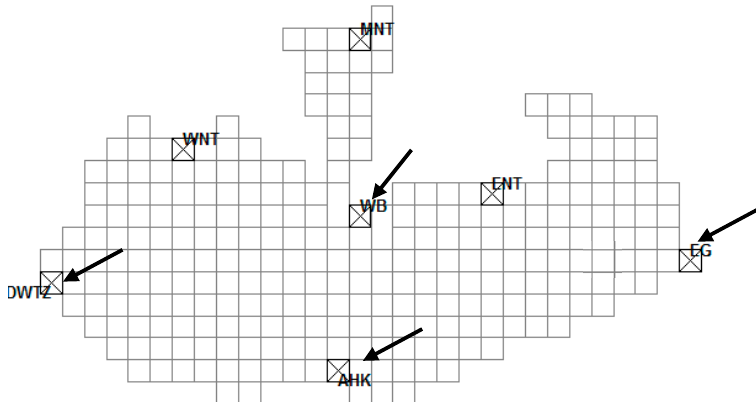
Figure 3. The computational grids and input and output boundary in the model (where the grids with a cross are the inlet and outlet cells, in which WB represents the inlets of the west branch of Kaidu River; DWTZ and AHK represent Dawutizha gate, and Ahongkou gate; WNT, MNT, and ENT represent the west, middle, and east agriculture drainage points, respectively; the black arrows show the schematic flow direction of the inlets and outlets) .